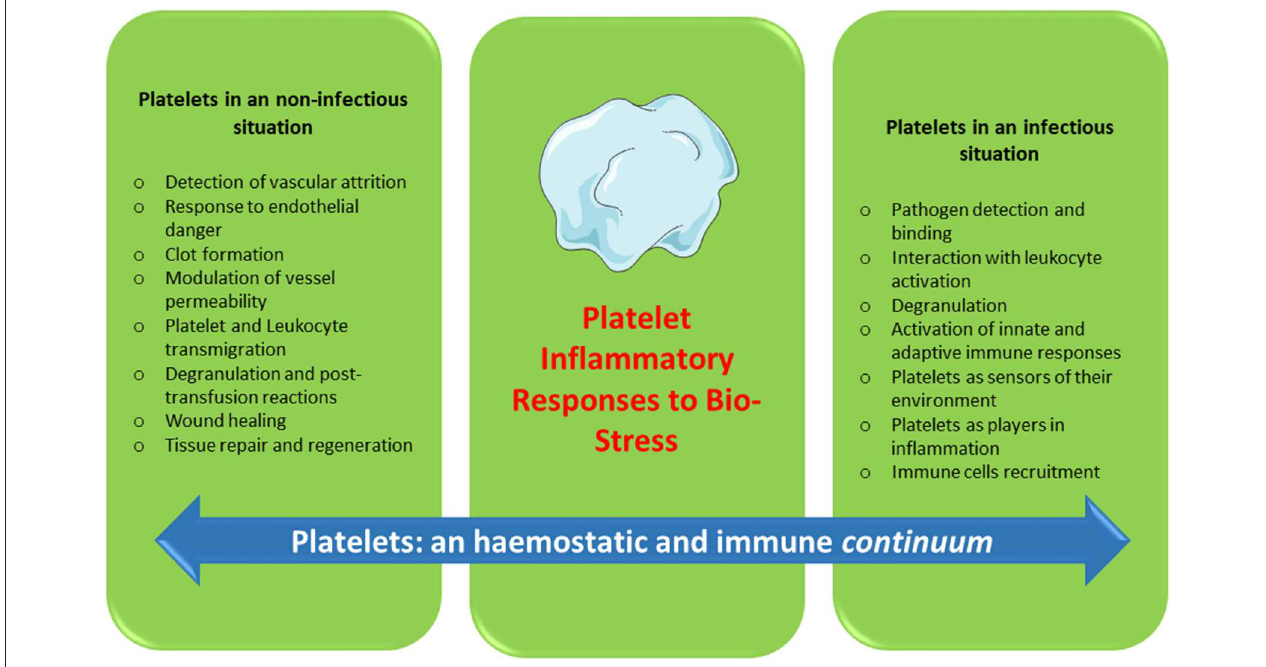
FIGURE 1 | Platelets: an hemostatic and immune